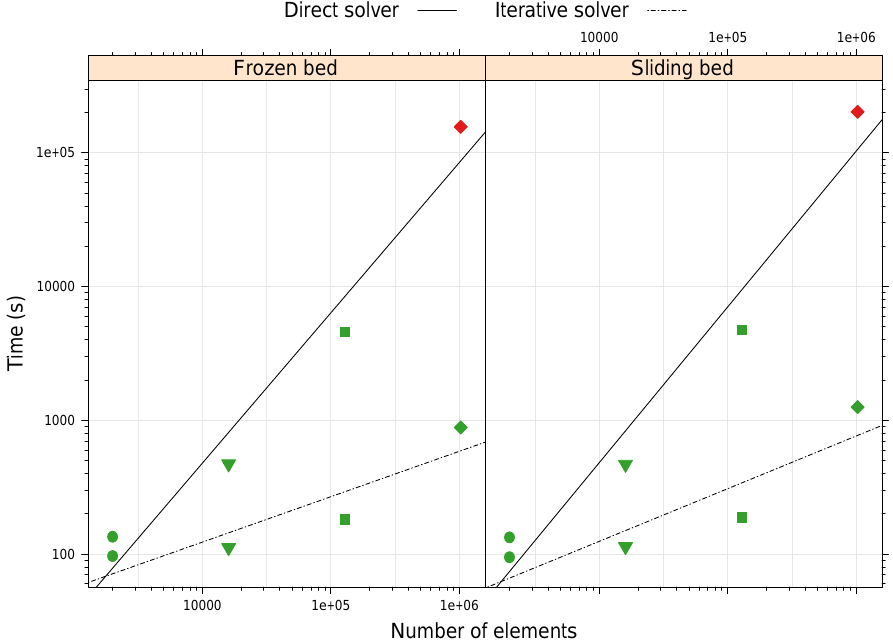
Figure 5. Weak scalability for simulating ISMIP-HOM Experiment F using the default ISSM solver (MUMPS), compared with a combi- nation of robust solvers (selected from the highlighted solvers in Figs. 2–4) for each analysis component of the transient simulation. This combination consists of a point block Jacobi (pbjacobi) preconditioned biconjugate gradient stabilized (bcgsl) iterative method for the mass- transport analysis, a block Jacobi (bjacobi) preconditioned minimum residual (minres) iterative method for the horizontal velocity analysis, and a point block Jacobi (pbjacobi) preconditioned conjugate gradient on the normal equations (cgne) for the incompressibility analysis. These simulations are conducted using a constant ratio of 500 elements per CPU (except for the largest model with the direct solver) and show the impact of increasing mesh size on simulation time (seconds). Ideal weak scaling is consistent with a horizontal slope. Timing results include the CPU time associated with assembling the stiffness matrix and load vector, solving the system of equations, and updating the input from the solution. See Fig. 2 for more